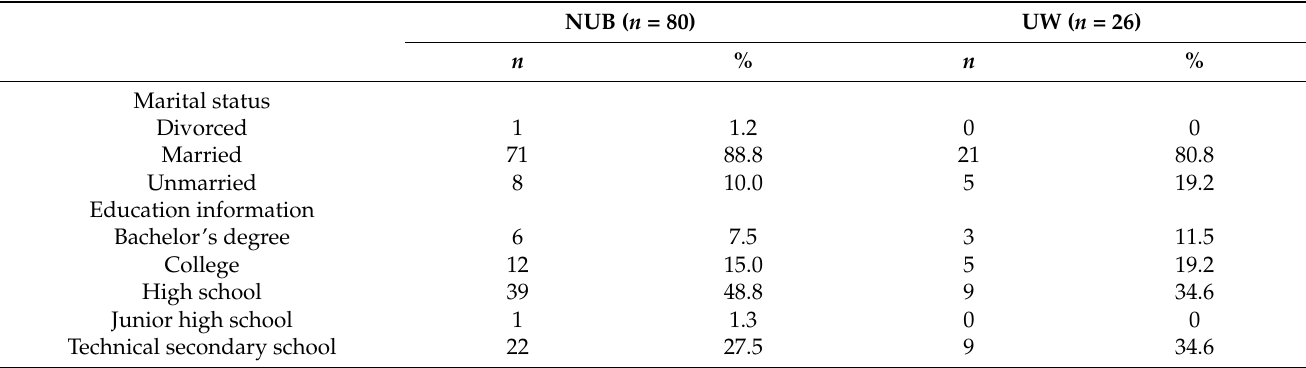
Table 2. The marital status and education information of 106